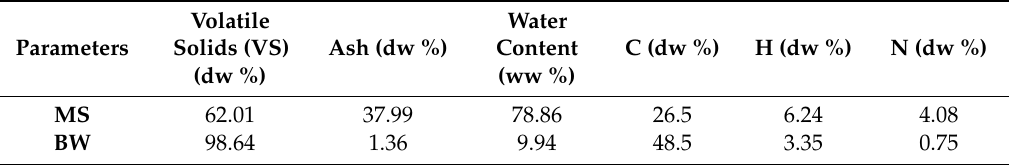
Table 1. Characteristics of municipal sludge (MS) and bamboo waste